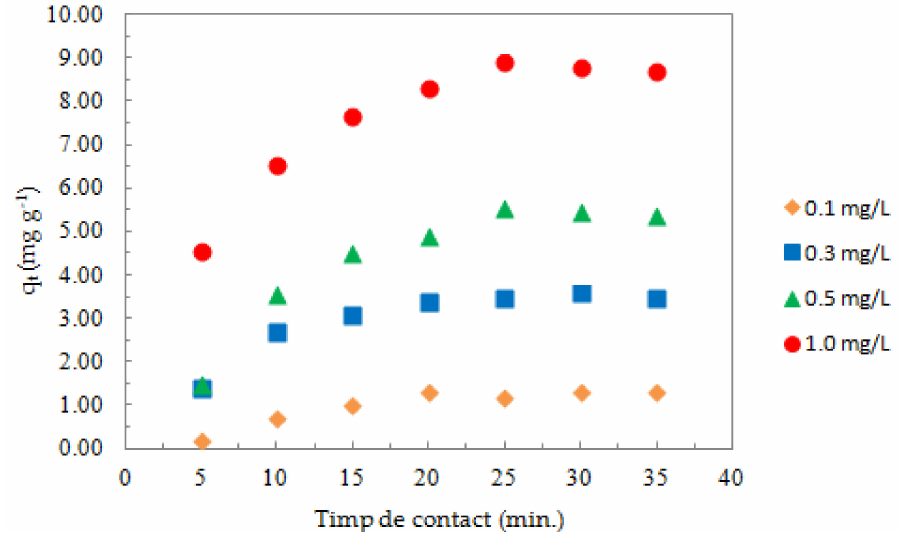
Figure 7. The effect of the initial Sb (III) concentration on its sorption on ox-xGnP (pH 7.0, 1.0 mg of ox-xGnP/100 mL solution, T = 20 ◦